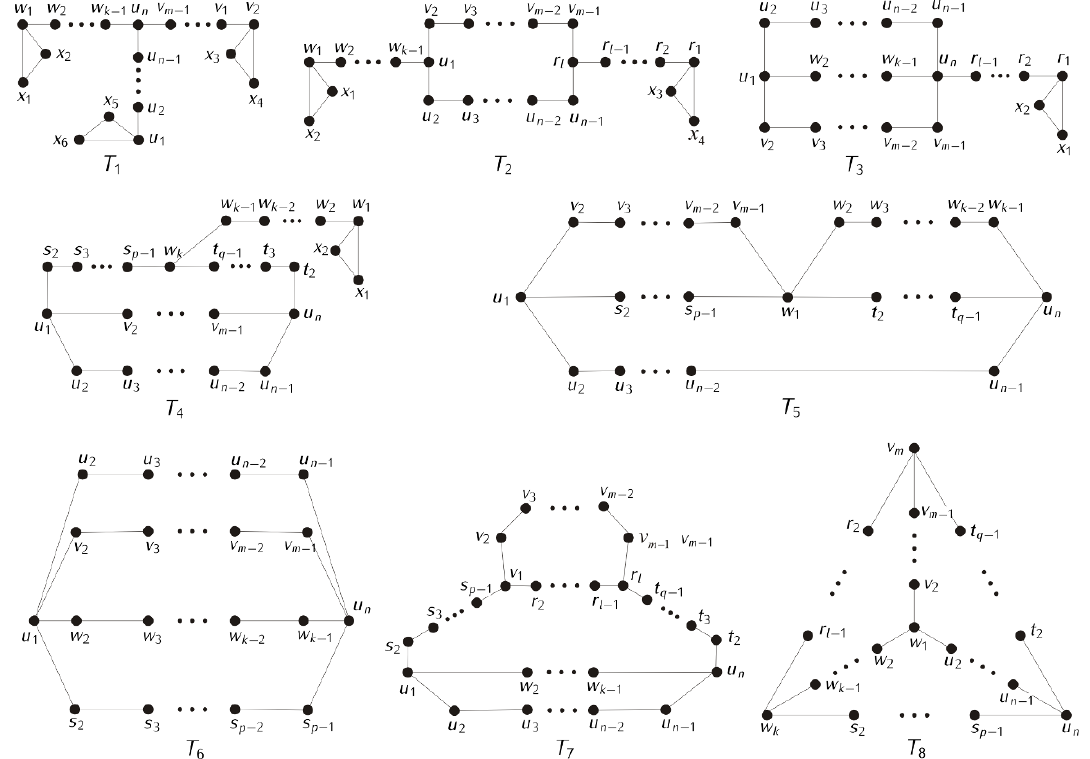
Figure 2. Graphs T